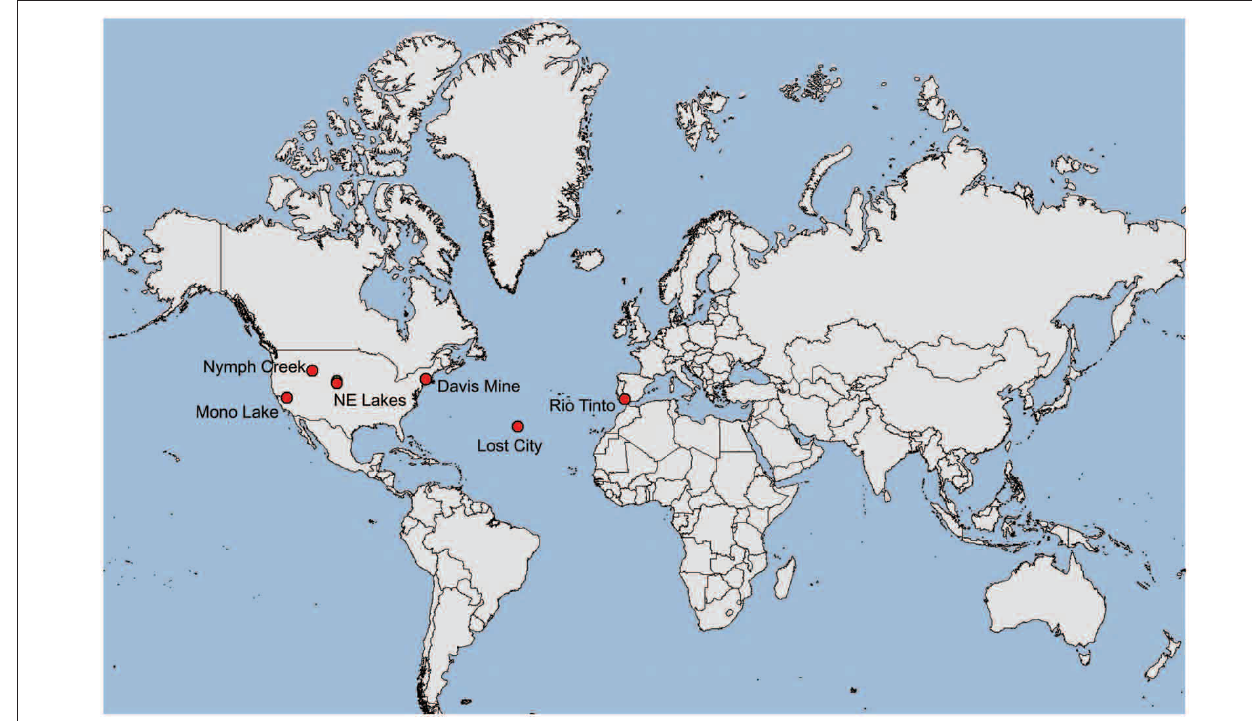
FIGURE 2 | Map of sampling site